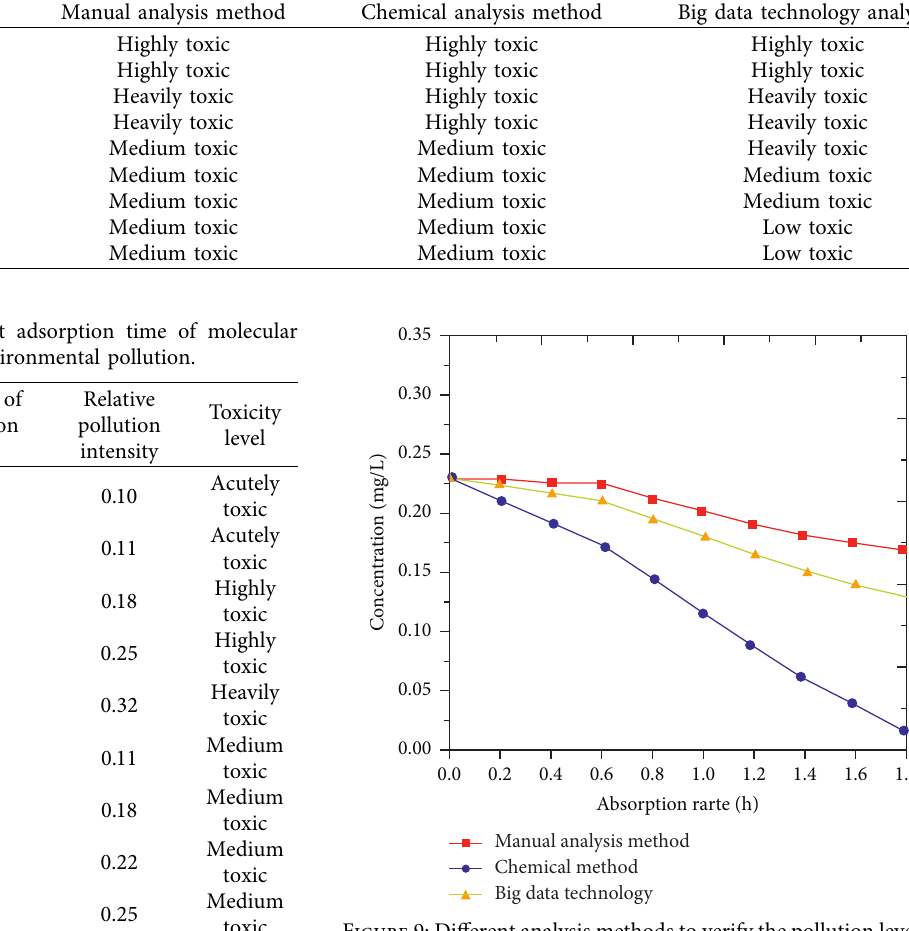
Table 6: Three analysis methods to verify the pollution level of molecular toxicity.